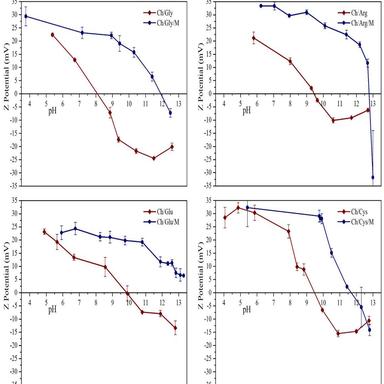
Measurements of Z potential against pH for modified chitosans before and after methylation.